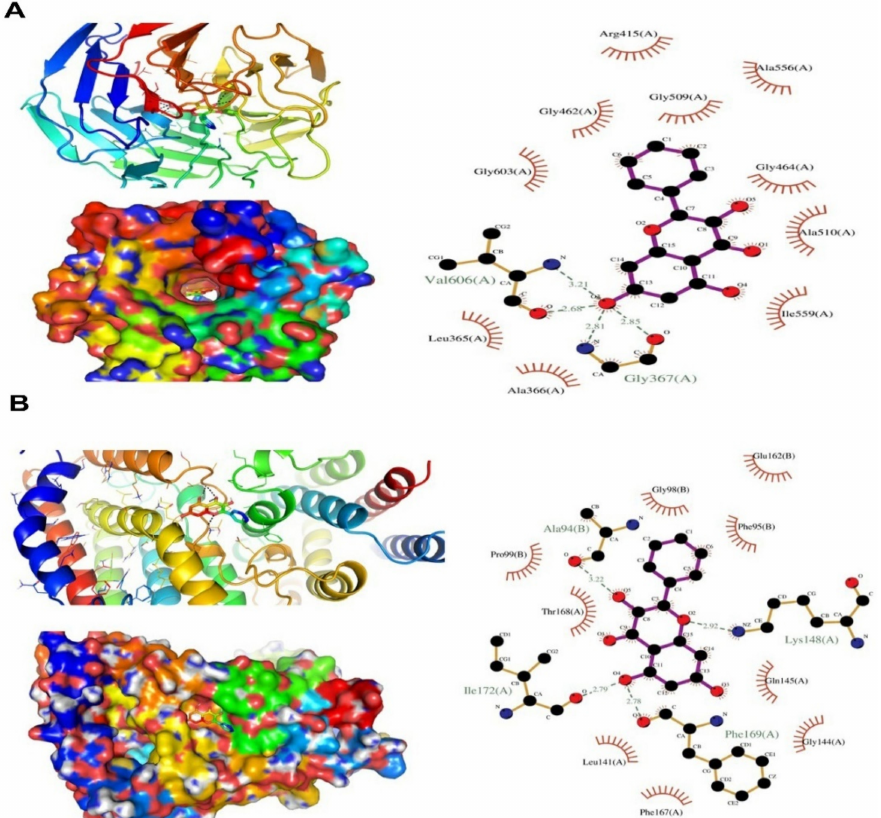
Figure 9. Molecular docking models of galangin with Keap1 and HO-1. ( A ) Galangin forms elec- trostatic interactions with Keap1, including four polar bonds with residues Gly367 and Val606, and hydrophobic interactions with residues Leu365, Ala366, Arg415, Gly462, Gly464, Gly509, Ala510, Ala556, Ile559, and Gly603. ( B ) Galangin forms four strong polar bonds with the residues Ala94, Lys148, Phe169, and Ile172, and hydrophobic interactions with the residues Ala94, Phe95, Gly98, Pro99, Leu141, Gly144, Gln145, Phe167, and Thr168 of